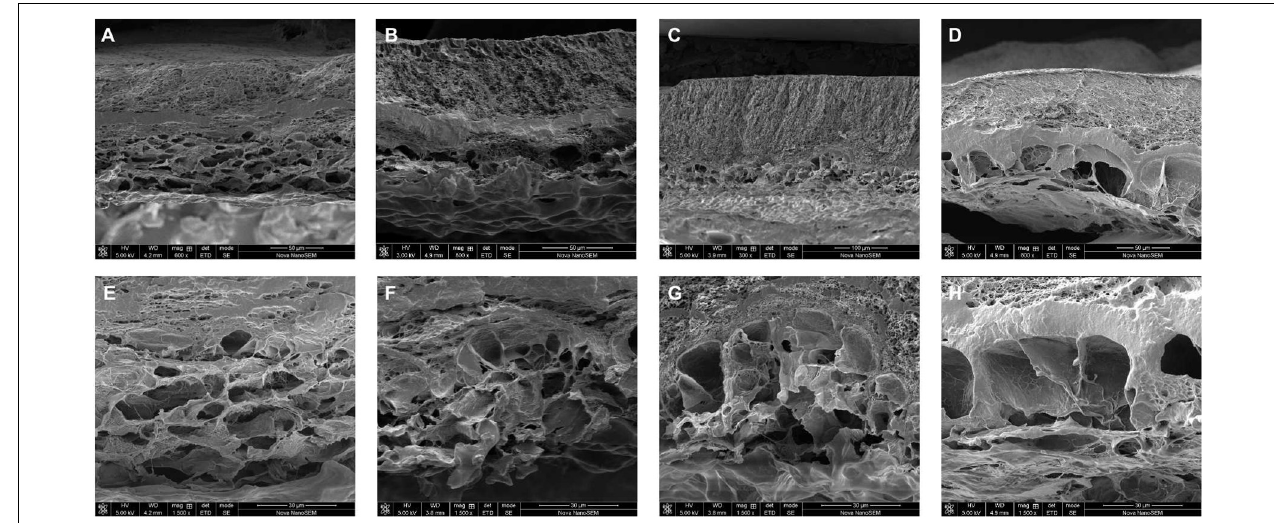
FIGURE 4 | Cross-section morphology of lyophilized Col/PVA dual-layer membranes after being immersed in PBS for (A) 4 days, (B) 8 days, (C) 12 days, (D) 17 days, and the corresponding magnified images of collagen layer at (E) 4 days, (F) 8 days, (G) 12 days, (H) 17 days.